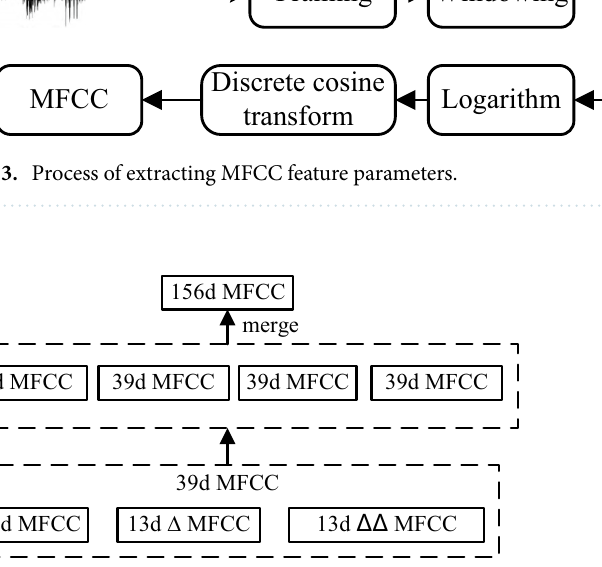
Figure 4. Extraction of birdsongs feature